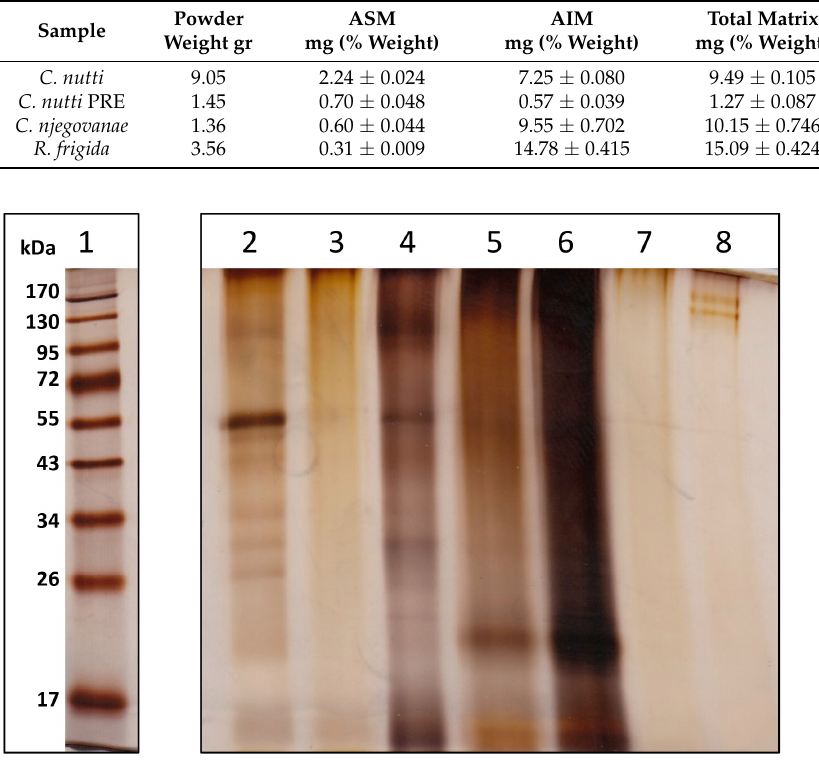
Figure 8. SDS-PAGE of skeletal organic matrices. Lane 1: Molecular weight markers, from up to down: 170, 130, 95, 72, 55, 43, 34, 26 and 17 kDaltons. Lanes 2–4 Cellarinella nutti : 2. ASM (10 µL), 3. PRE-ASM (20 µL); 4. LS-AIM (10 µL). Lanes 5–6 Cellarinella njegovanae : 5. ASM (20 µL), 6. LS-AIM (10 µL); Lanes 7–8 Reteporella frigida : 7. ASM (10 µL), 8. LS-AIM (20 µL). ASM: Acid-soluble matrix. LS-AIM: Laemmli-soluble acid-insoluble matrix. PRE= pre-bleached. Loaded solutions: 10 or 20 µ